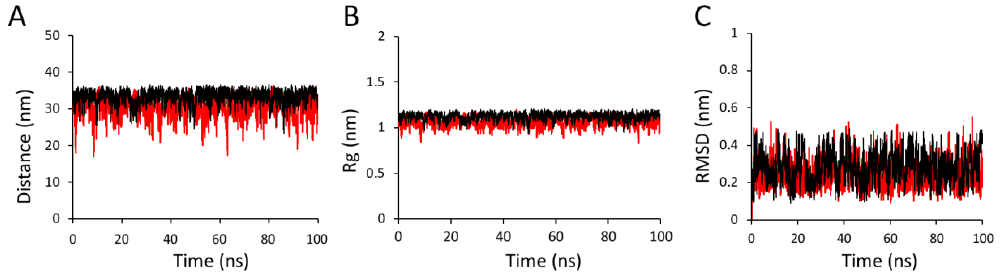
Figure 5. Global properties of an HA octasaccharide molecule: ( A ) End-to-end distance (R e ), ( B ) Radius of gyration (R g ), and ( C ) root mean square deviation (RMSD). Black and red lines indicate AA and CG representations, respectively.